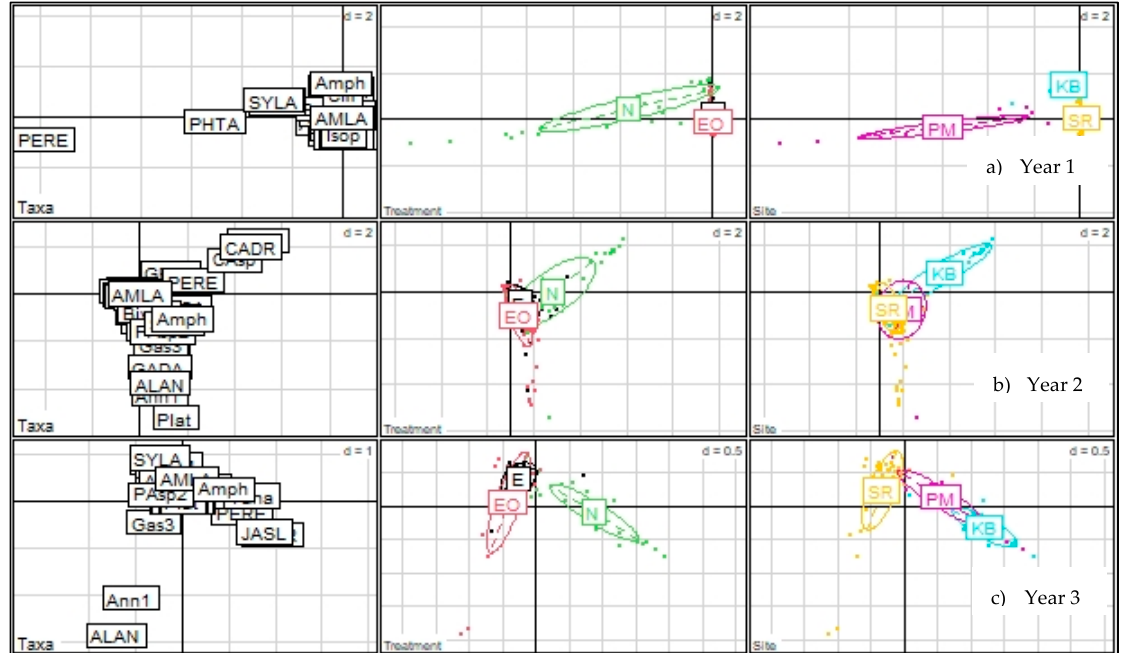
Figure 5. Correspondence analysis of taxa detected over the course of three monitoring years from shoot samples from restored eelgrass within eelgrass only (E) and eelgrass and oyster combination plots (EO) from San Rafael (SR), and natural (N) eelgrass populations from Keller Beach (KB) and Point Molate (PM). Panels show taxa ( left ) coded by treatment ( center ) and site ( right ), with ( a ) Year 1 monitoring results (Factors 1 and 2, Inertia = 38.24%), ( b ) Year 2 monitoring results (Factors 1 and 2, Inertia = 29.64%), and ( c ) Year 3 monitoring results (Factors 1 and 2, Inertia = 30.89%). Treatment abbreviations as in previous figures; taxa abbreviations detailed in Appendix A Table A3.